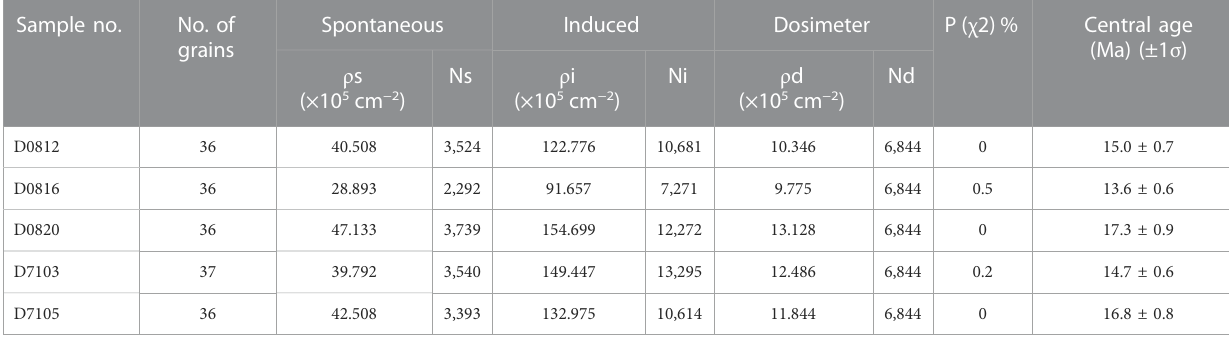
TABLE 4 Zircon fi ssion track results from the Kangmar dome. Sample